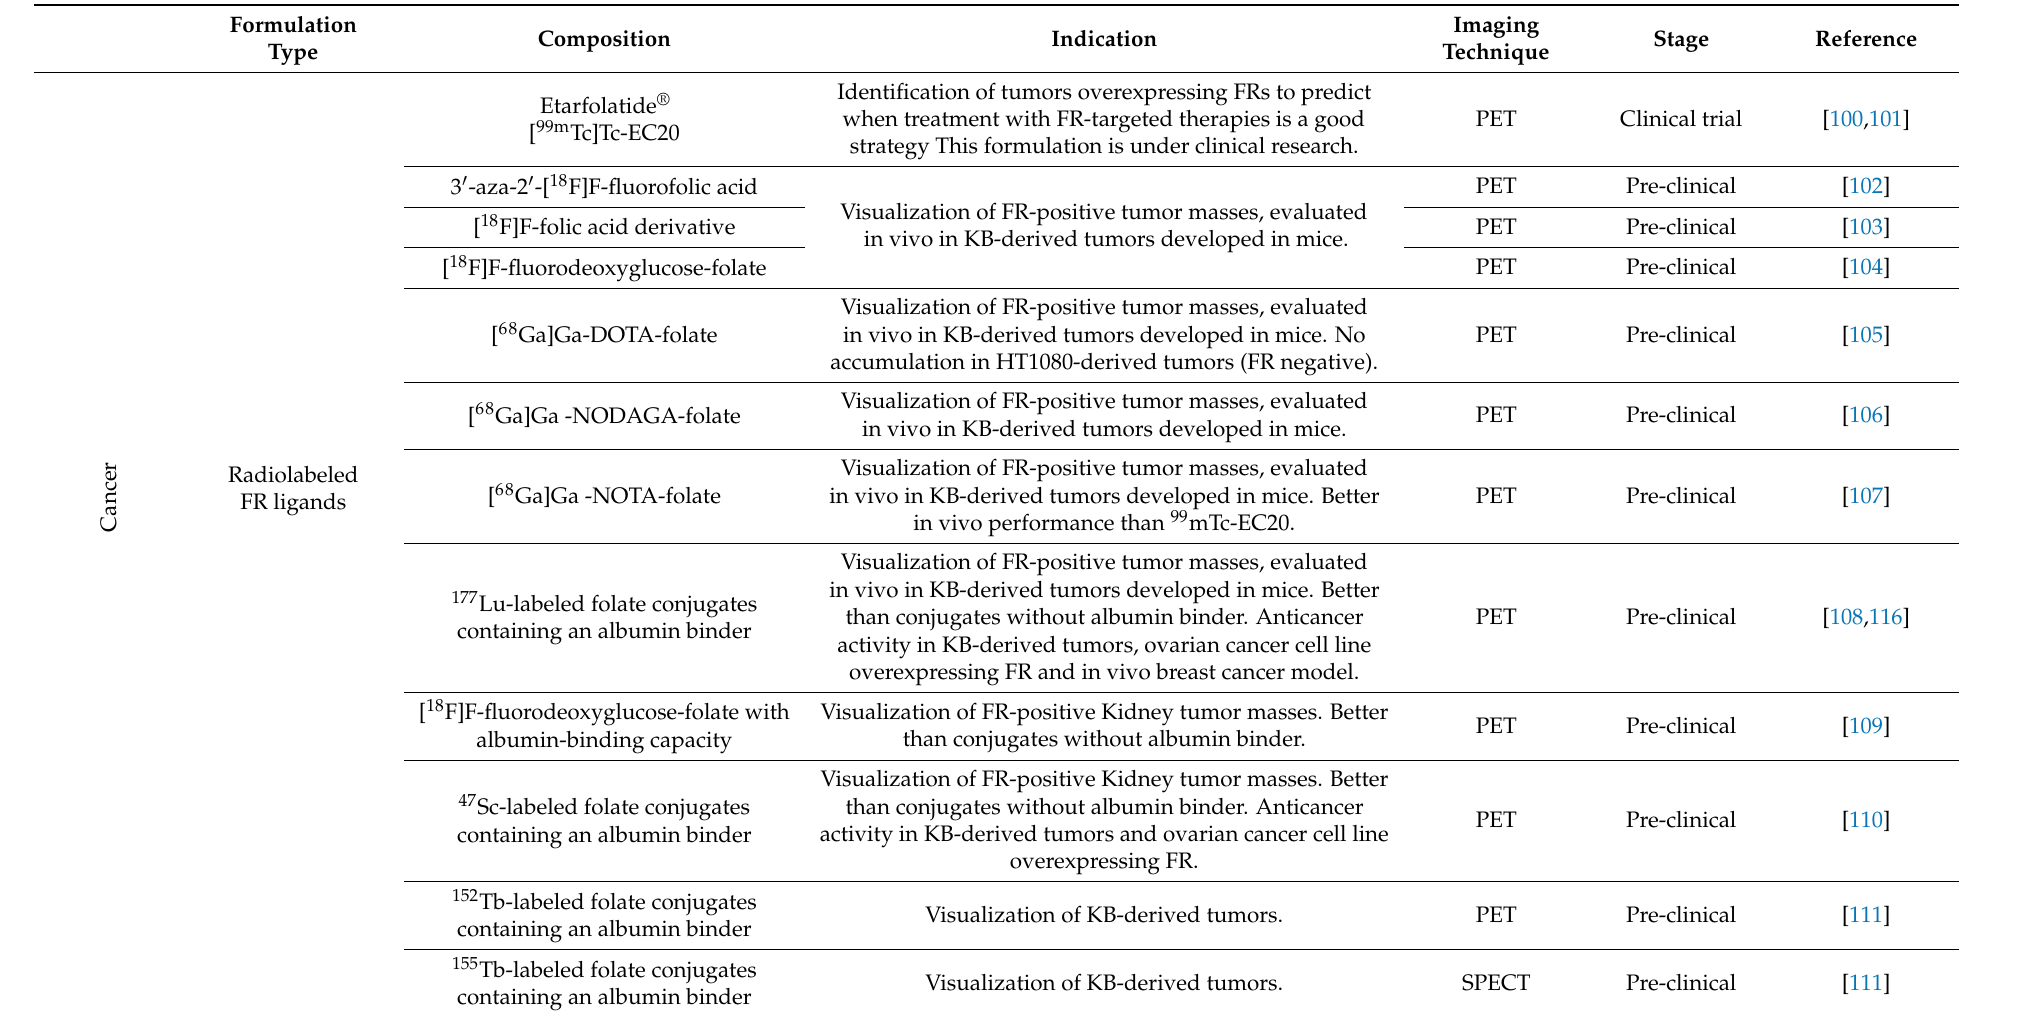
Table 3. FR-targeted nanoformulations for imaging or theranostic purposes in cancer and inflammatory diseases: PET: Positron emission tomography, SPECT: Single-photon emission computed tomography, MRI: magnetic resonance imaging, NIFI: Near infrared fluorescence imaging. Formulation Imaging